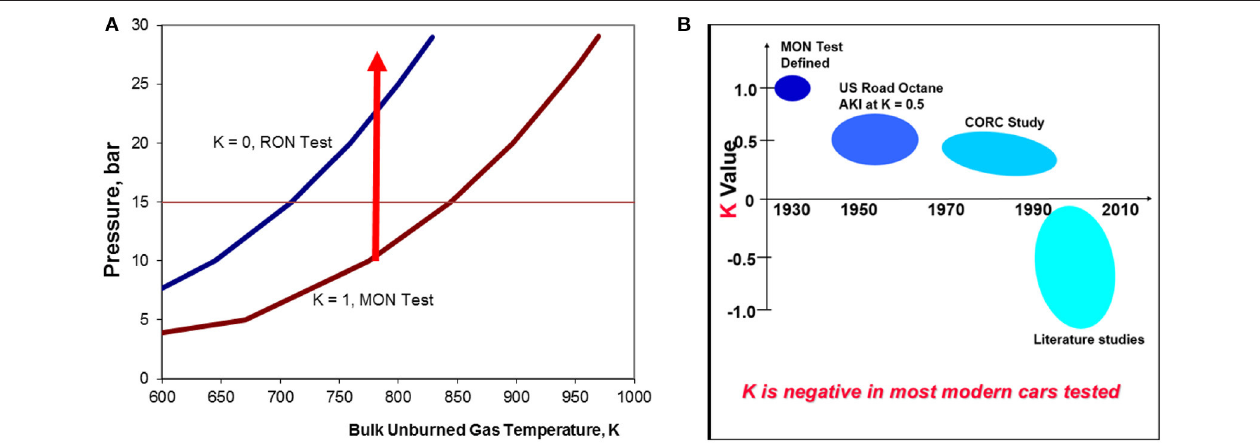
FIGURE 1 | (A) Pressure vs. unburnt gas temperature in the RON and MON test. SI engines have evolved along the direction of the red arrow as a result of increasing desire for higher efficiency and power density over the past decades (Kalghatgi and Stone, 2017); (B) the average engine K -values have declined over the years with some modern engines already operating beyond RON conditions so that K is negative (CONCAWE,